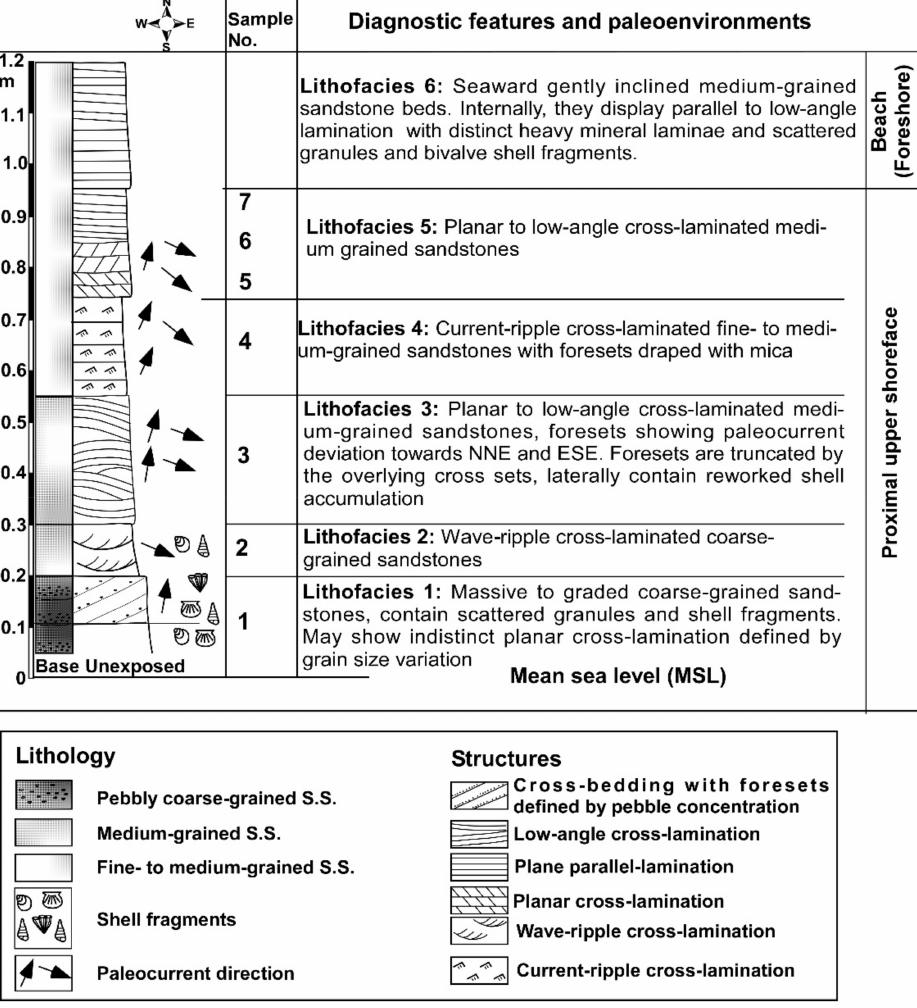
Figure 2. The sedimentary log, location of analyzed samples, and the lithofacies characteristics that were recognized from the Al-Mejarma beachrock (see Figure 1 for